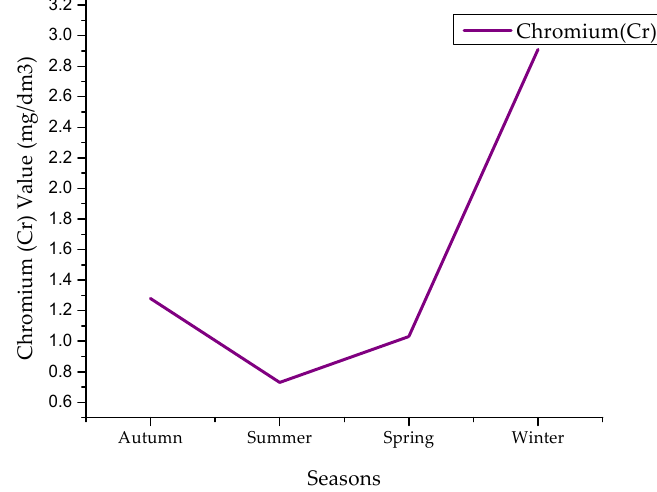
Figure 12. Concentration values for (Cr) from image during four seasons.